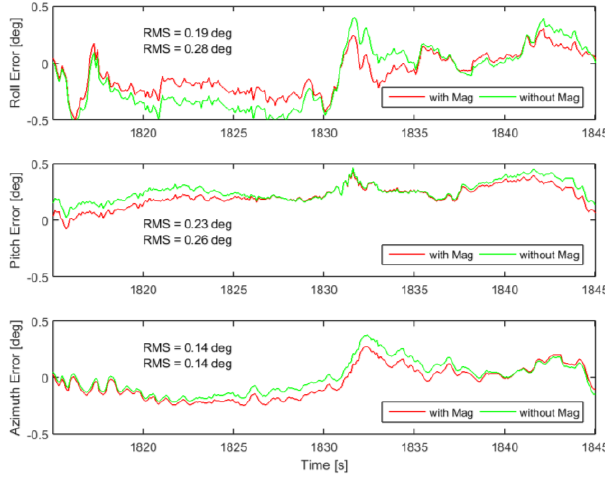
Figure 12. Attitude errors for ADIS IMU during RTK signal outage